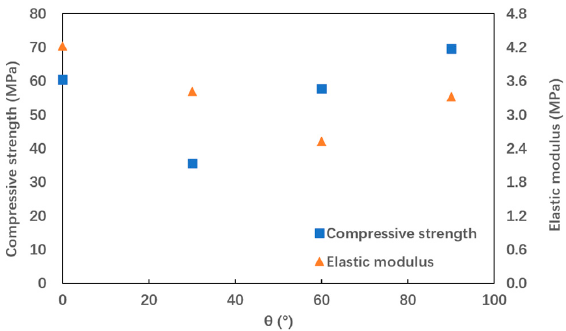
Figure 11. Compressive strength and elastic modulus of shale specimens with different bedding angles.